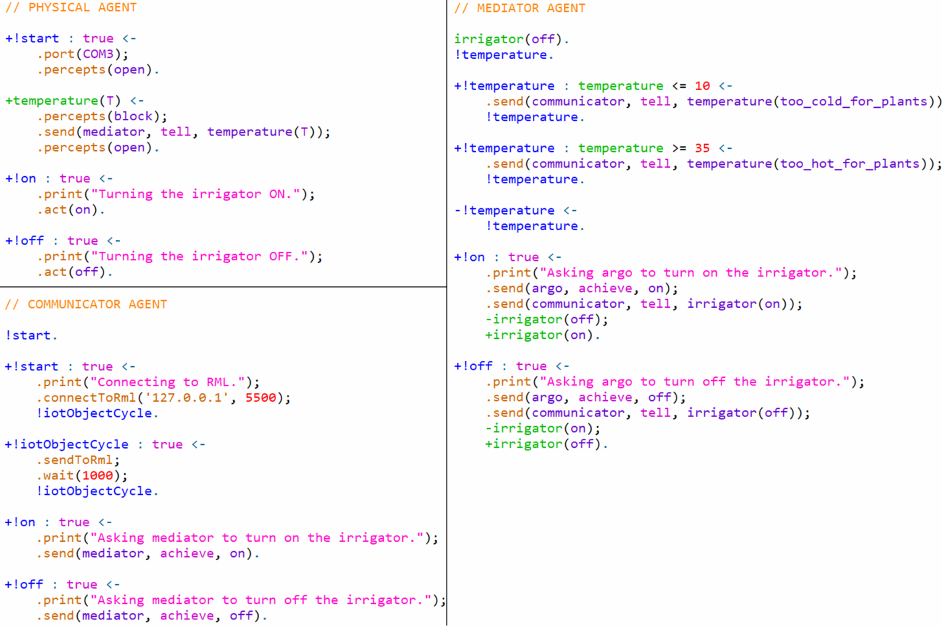
Figure 6. The Agent Approach